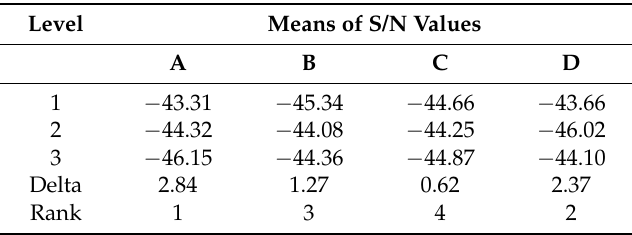
Figure 7. Main effects plot for signal-to-noise (S/N) ratios [Response: Diameter]. Table 5. Response table for means of signal-to-noise (S/N)